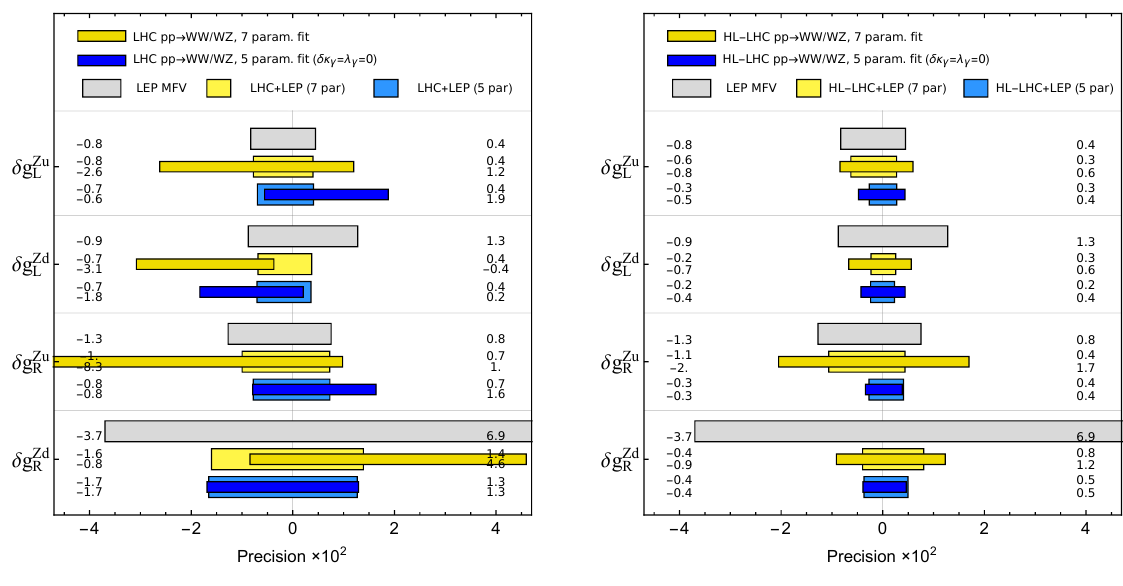
Figure 10 . Current ( left ) and future ( right ) 95% CL constraints on the anomalous vertices among light quarks and electroweak bosons. In gray, we show LEP-1 results assuming MFV. In yellow we use LHC diboson data and perform a global (cid:12)t including the aTGCs. In blue, we only pro(cid:12)le over (cid:14)g 1 z and the vertex corrections. The thicker boxes combine LHC and LEP-1 data.